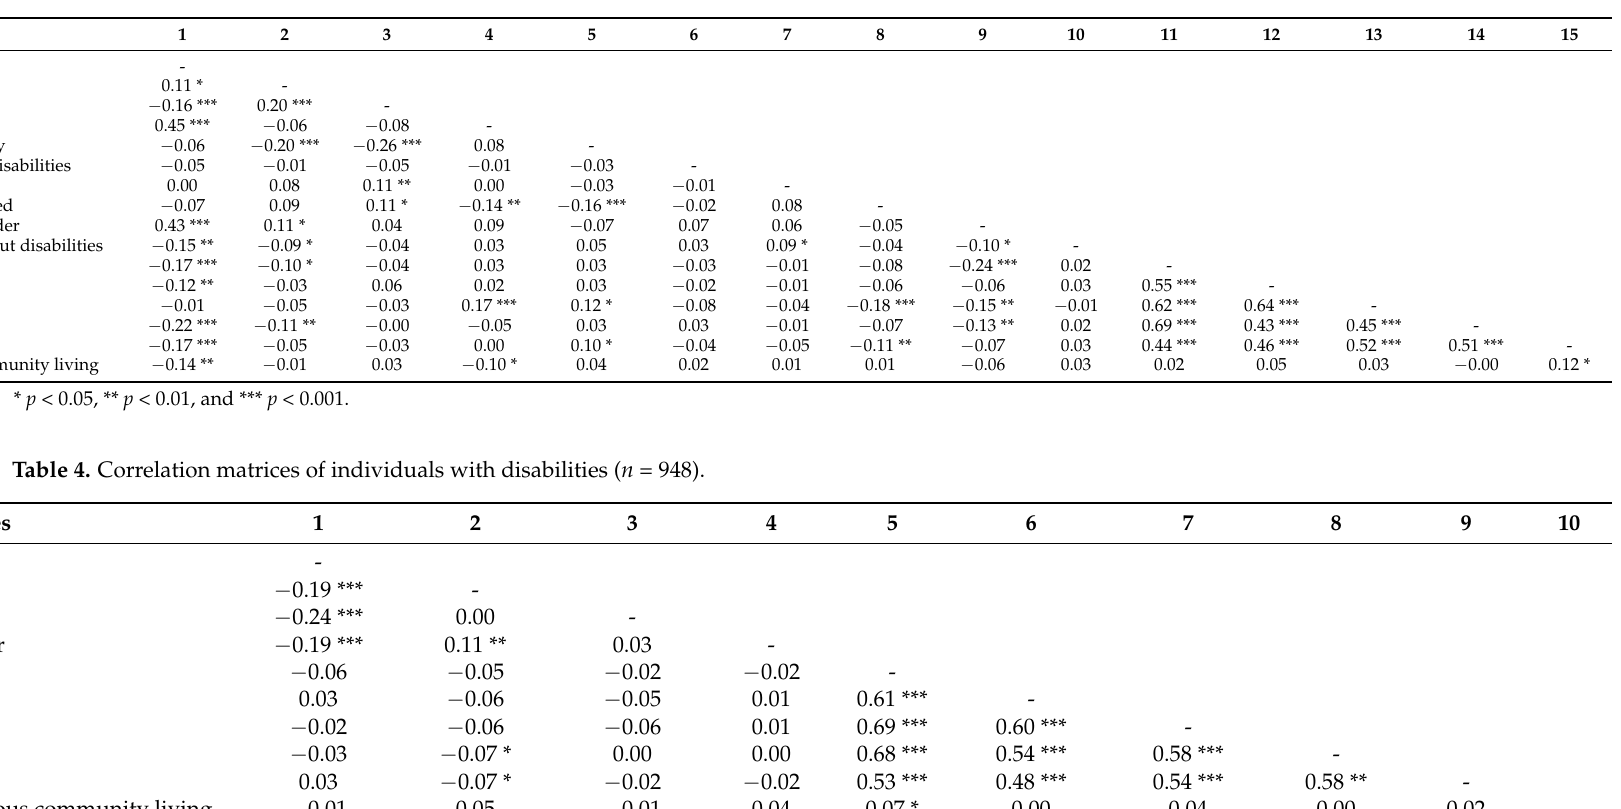
Table 3. Correlation matrices of caregivers ( n = 522).